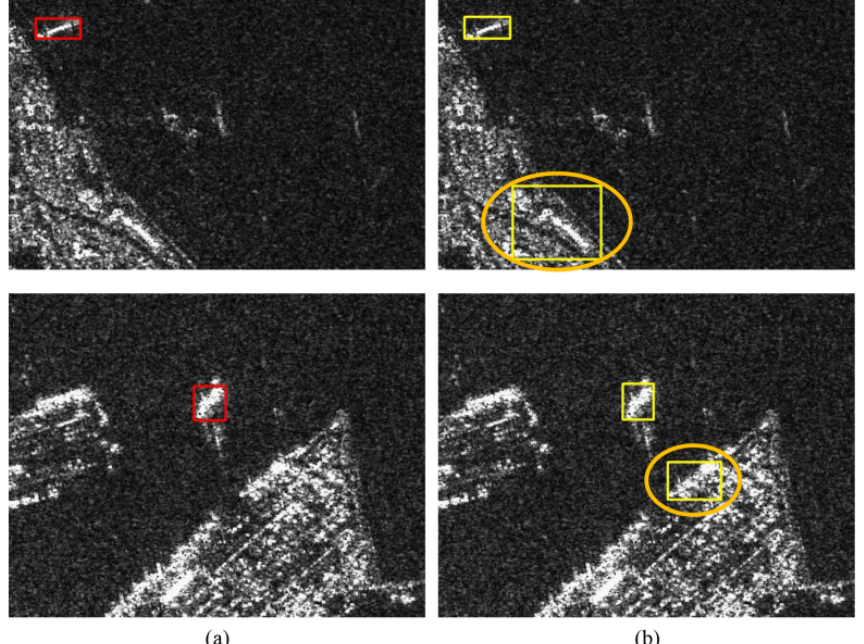
Figure 2. Visualization of the false alarm phenomena of the detector. ( a ) The ground-truth objects in SAR images. ( b ) Detection results of the model. The red bounding boxes denote the ground-truth objects. The yellow bounding boxes denote the detection results. The orange ellipses denote the false